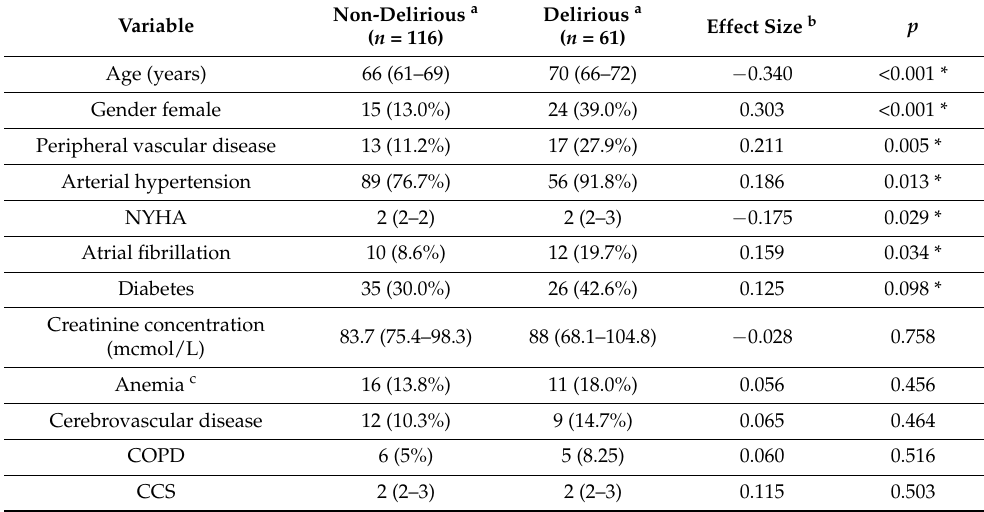
Table 1. Preoperative variables related to demography and physical condition of patients analyzed in a univariate analysis.